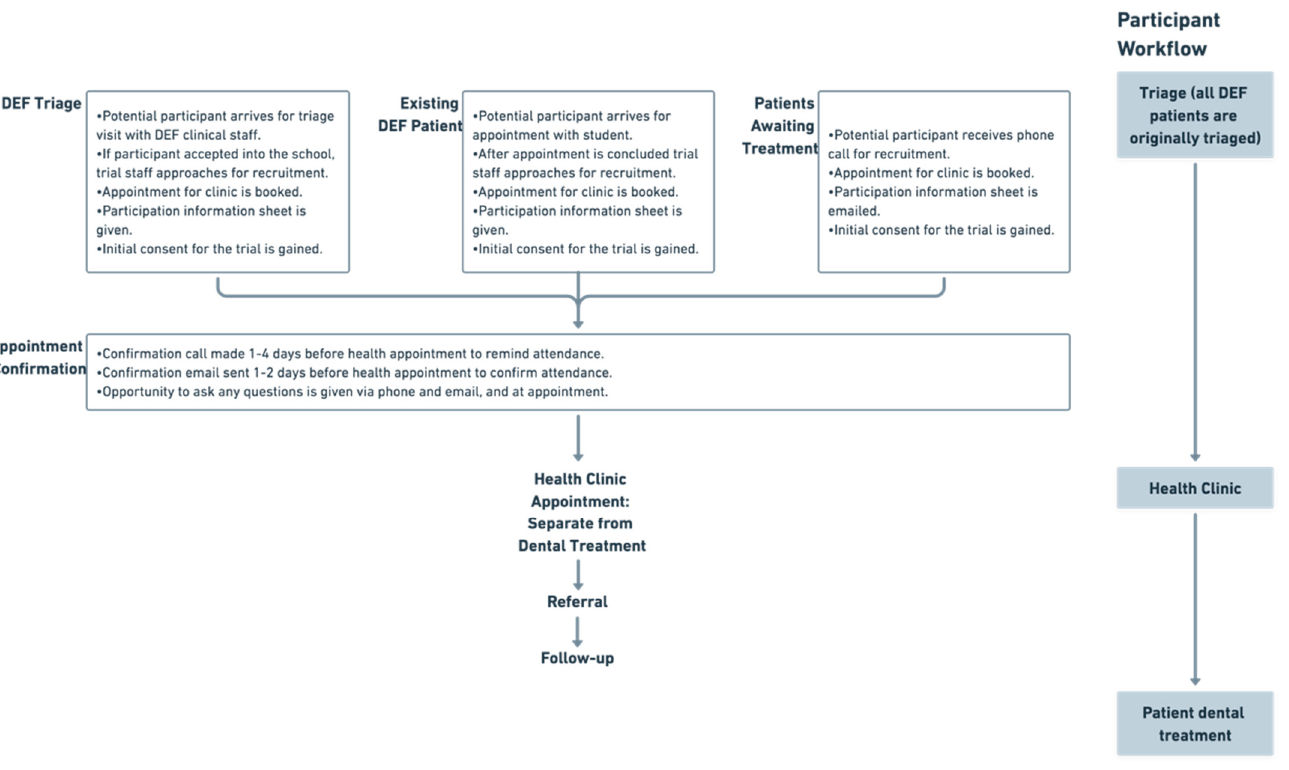
Figure 1. Pathway for recruitment of participants for hypertension case-finding within